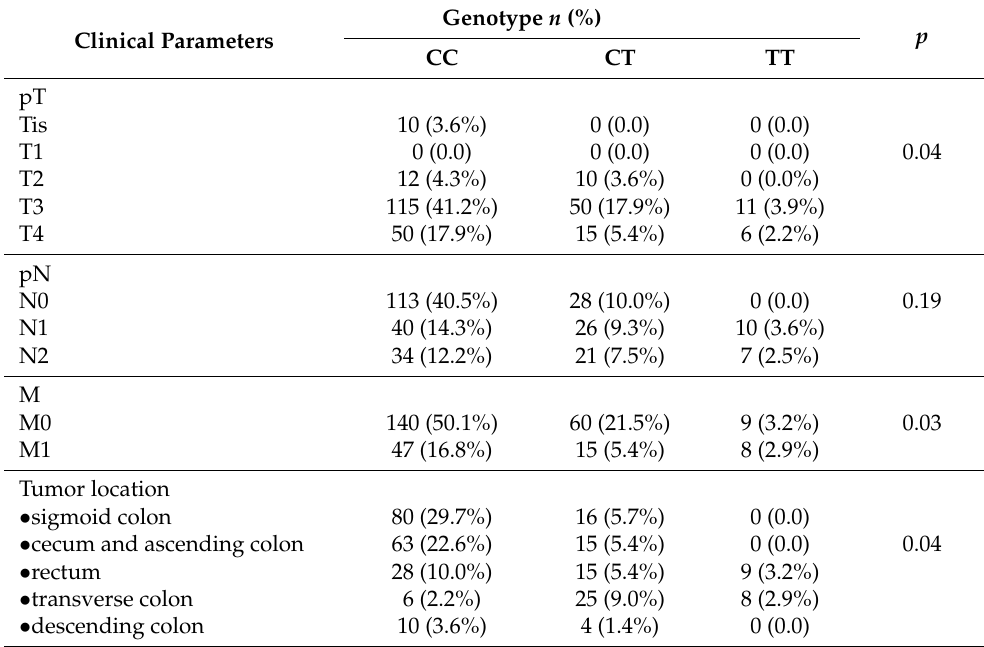
Table 2. Selected clinical parameters of patients with colorectal cancer and the NQO1 609C > T